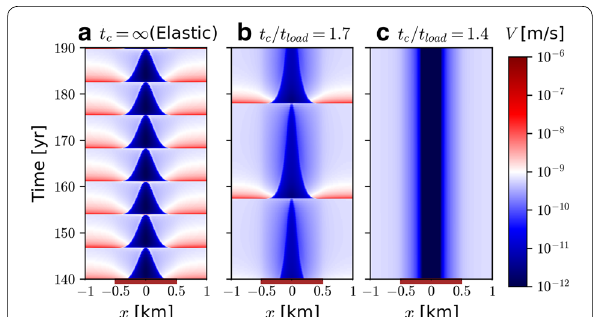
Fig. 4 Spatiotemporal distribution of V in viscoelastic cases with different t c / t load values. a An elastic limit, identical to the case plotted in Fig. 3a. The system produces repeating earthquakes every approximately 7.15 years ( = 3.38 t load ). b t c / t load = 1.7 . t c is approximately one-half of t rec in the elastic limit. Earthquakes repeat at a longer interval of 20.6 years ( = 9.74 t load ) than in the elastic case. c t